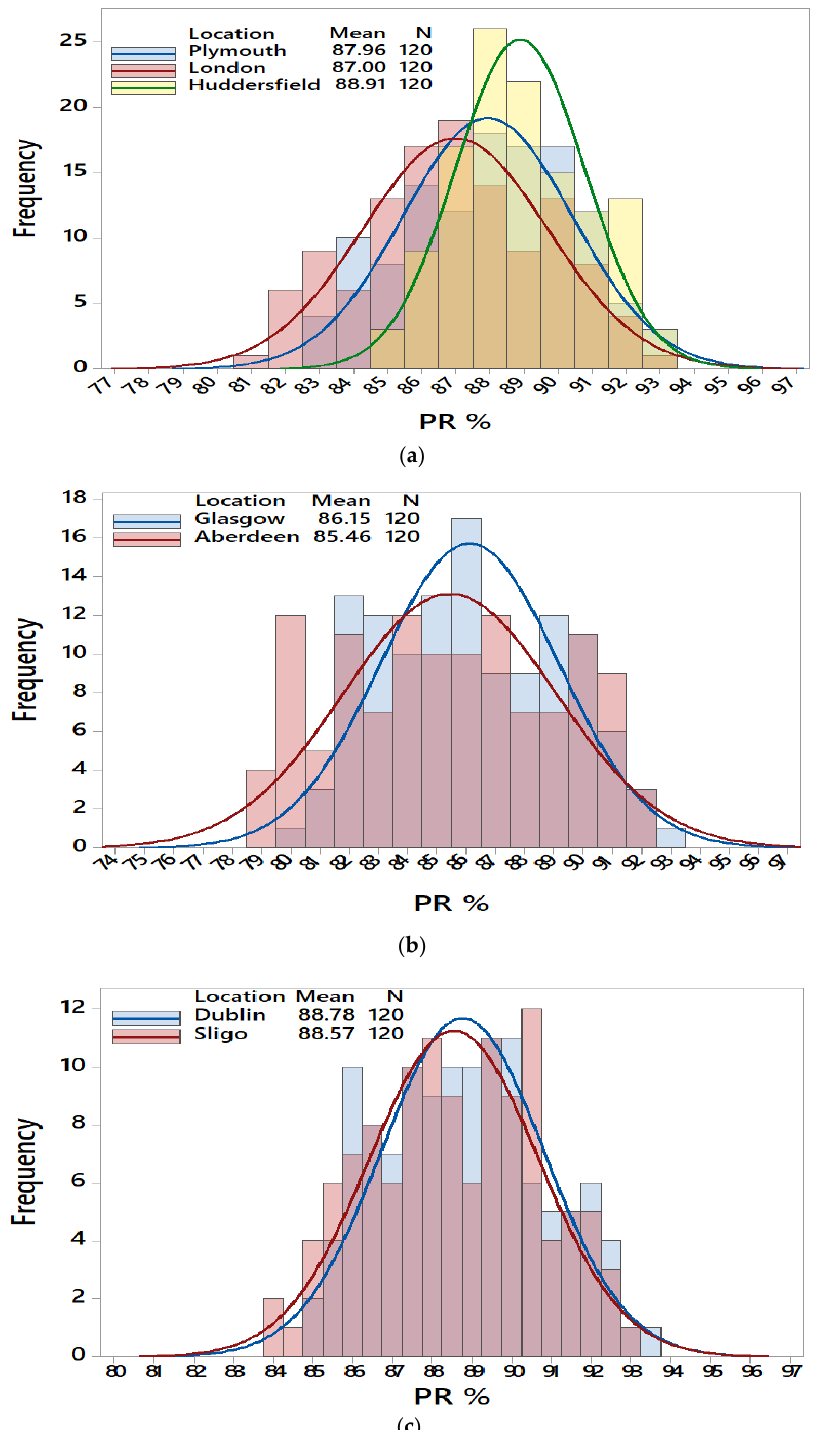
Figure 6. Performance ratio (PR) analysis for all examined PV systems: ( a ) PV systems installed in England; ( b ) PV systems installed in Scotland; ( c ) PV systems installed in Ireland.